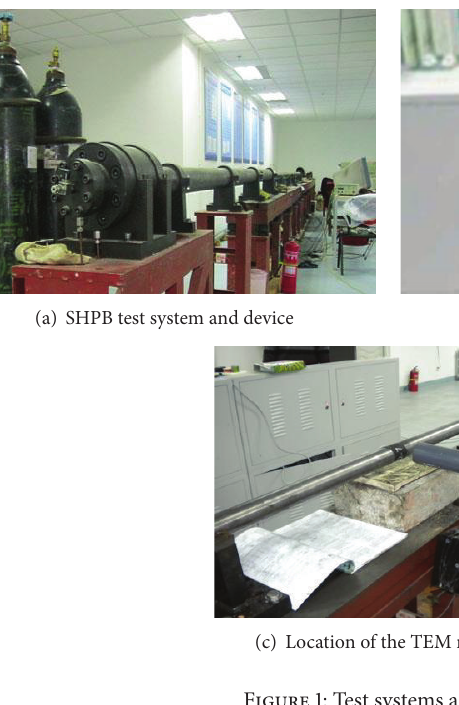
Figure 1: Test systems and their location.